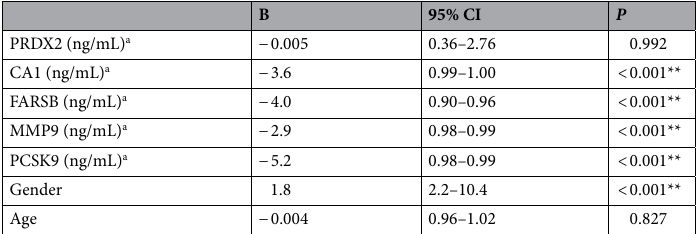
Table 3. Logistic Regression using protein levels to predict diagnosis of BD-II (training group). Reference group: normal control. Constant number: 33.732. Using logistic regression to form a probability score (combination of 5 protein levels) to predict diagnosis of BD-II. Probability score for the testing group is calculated in the following way: